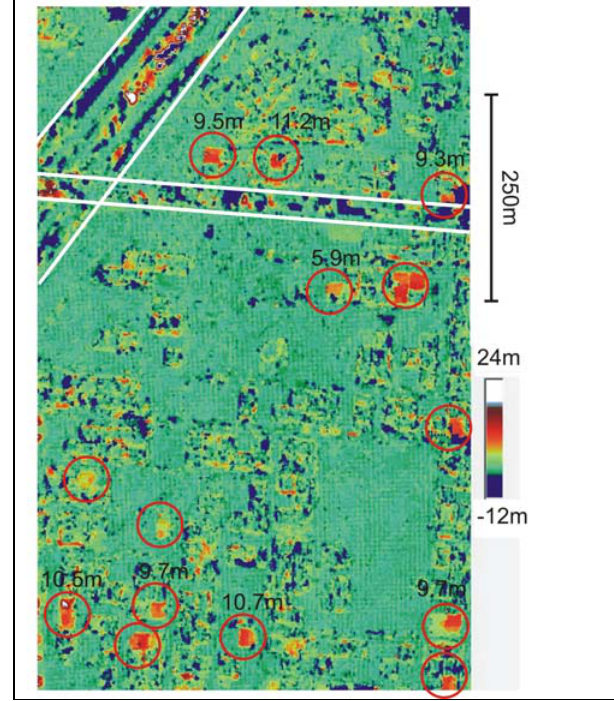
Figure 35: DSM differences – GeoEye-1 minus aerial 28cm GSD, based on LSM with marked building